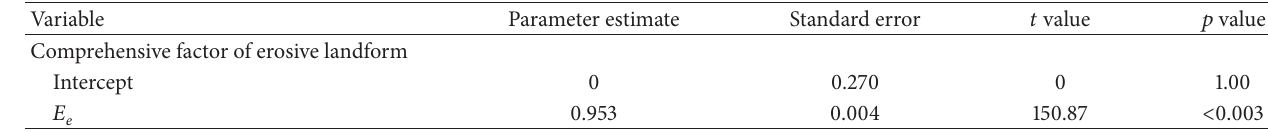
Table 3: The estimation parameters of the regression